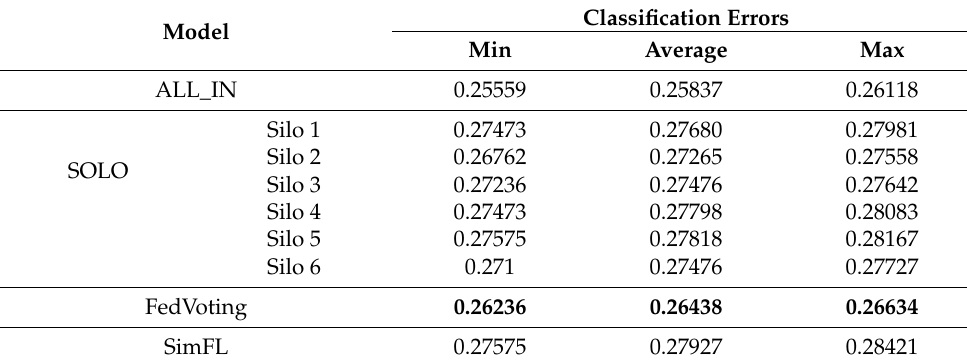
Table 4. Comparison of classification errors in Disneyland visit